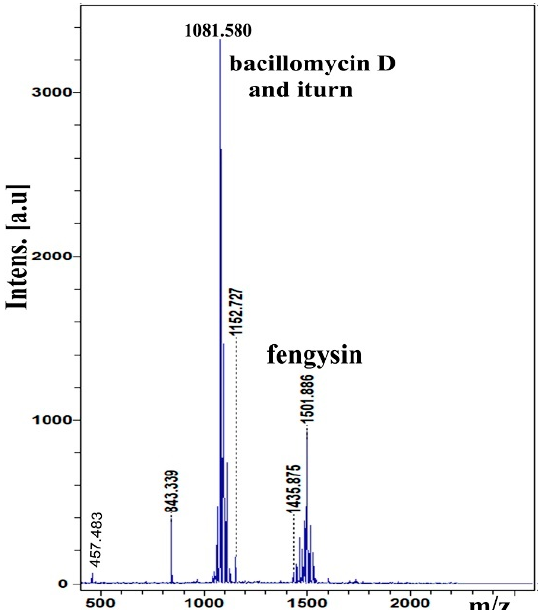
Figure 6. MALDI-TOF MS analysis of lipopeptide compounds produced by IMA13 strain.